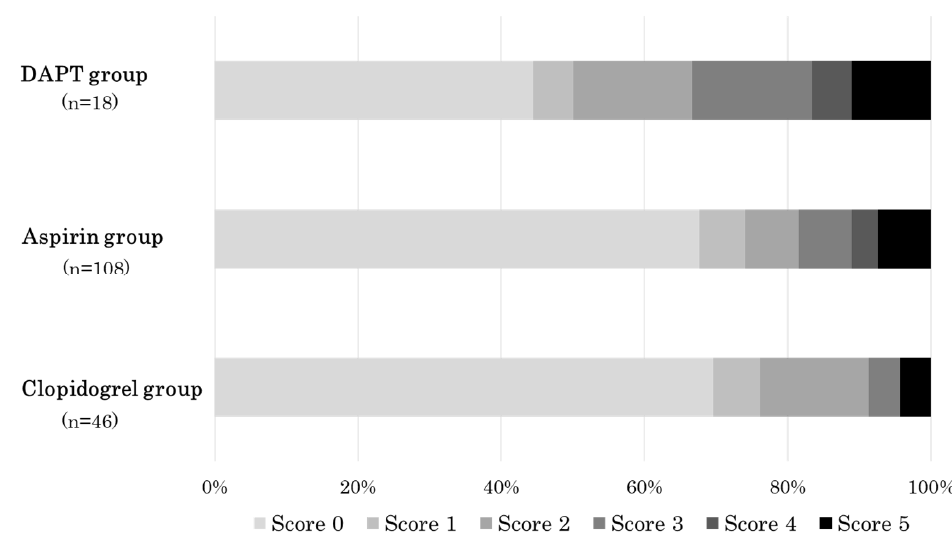
Figure 3. The proportions of patients with each modified Lanza score (m-Lanza score) in the DAPT group, aspirin group, and clopidogrel group. DAPT, dual antiplatelet therapy consisting of low-dose aspirin and clopidogrel.